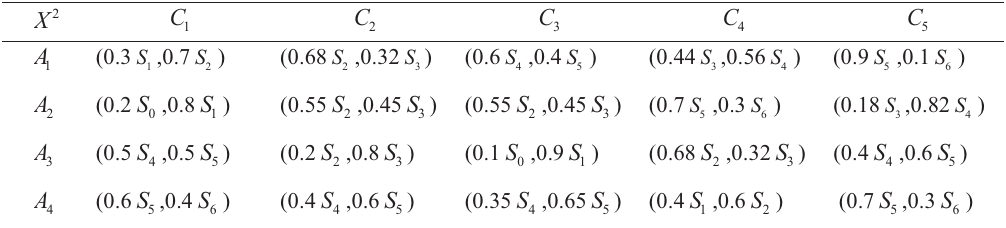
Table 2. The linguistic evaluation matrix 2 X provided by the decision maker